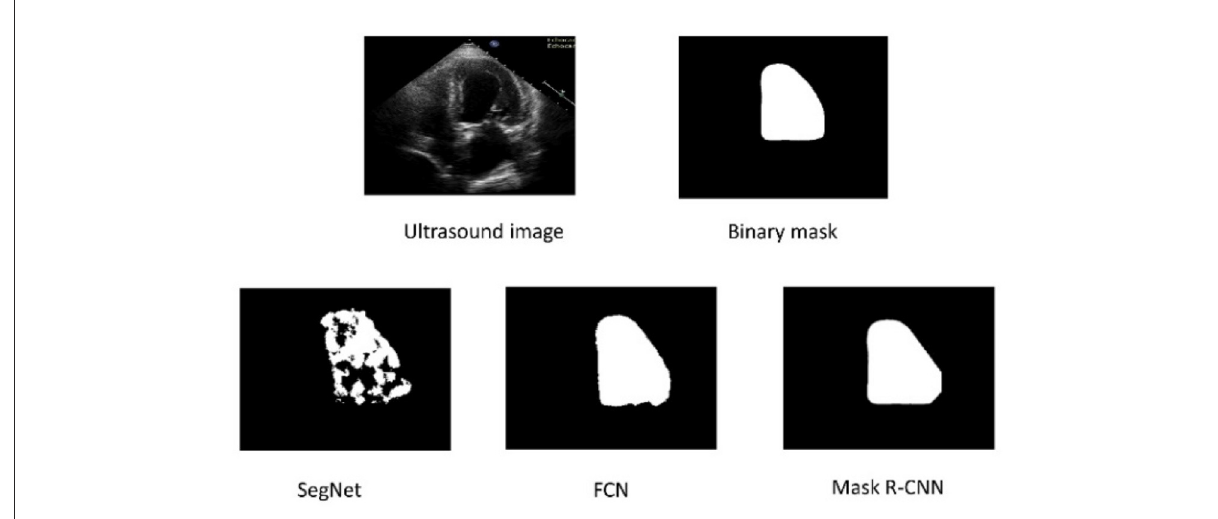
FIGURE4 The top row represents the original Ultrasound image and ground truth binary mask. The bottom row shows the segmented results of the three architectures.